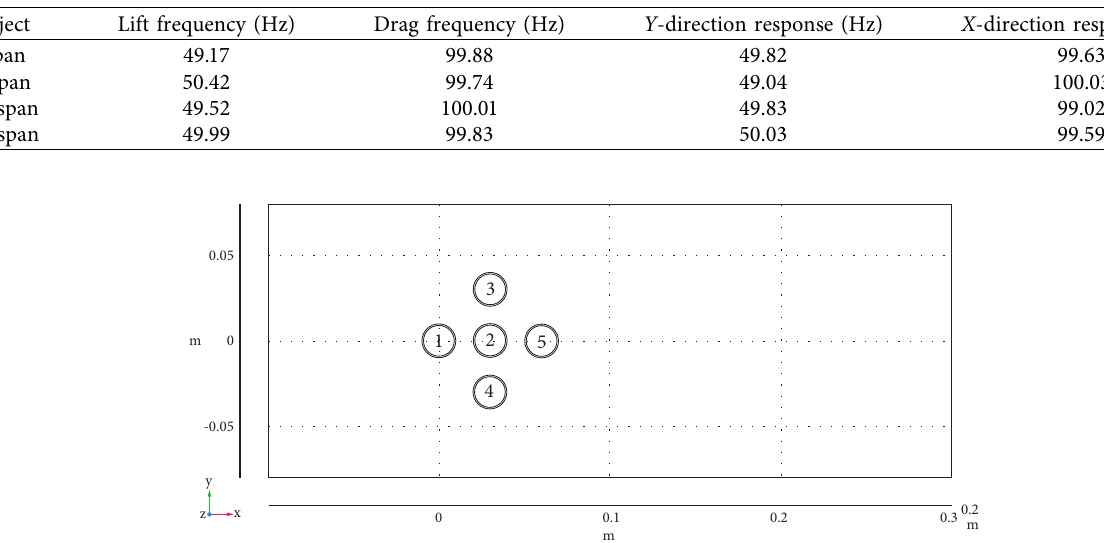
Figure 18: Vibration displacement curve of the four-span tube bundle. (a) I span. (b) II span. (c) III span. (d) IV span. Table 7: Lift, drag frequency, and axial displacement response frequency results for each span.